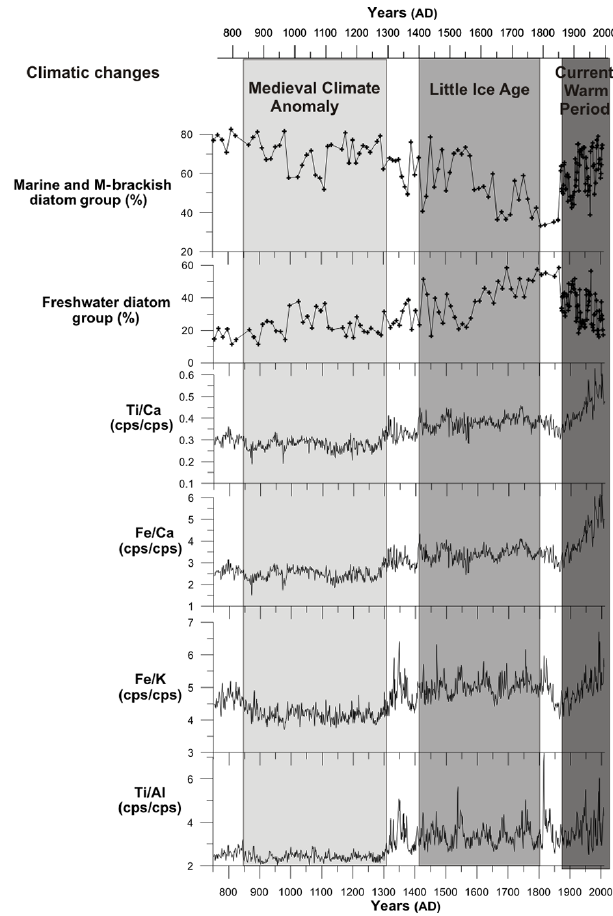
Figure 3. From bottom to top: centennial variation in Ti / Al, Fe / K, Fe / Ca, Ti / Ca ratios, and the freshwater and marine/marine-brackish salinity-indicative diatom groups from the sediment core GeoB 13813-4 during the last 1200yrBP (750– 2000calyrAD). The major climatic changes during this period of time were the Medieval Climatic Anomaly and the Little Ice